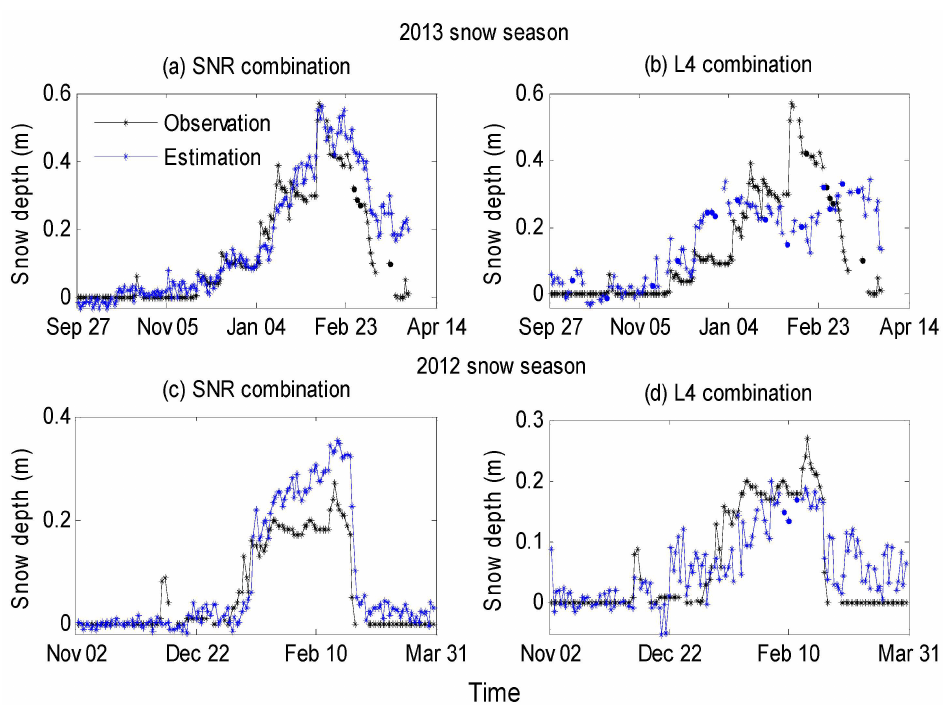
Figure 8. Snow thickness changes at IGS station GANP in 2012 and 2013 from the combined GPS and GLONASS observations with geometric-free combination (L4) and signal-to-noise ratio (SNR), respectively